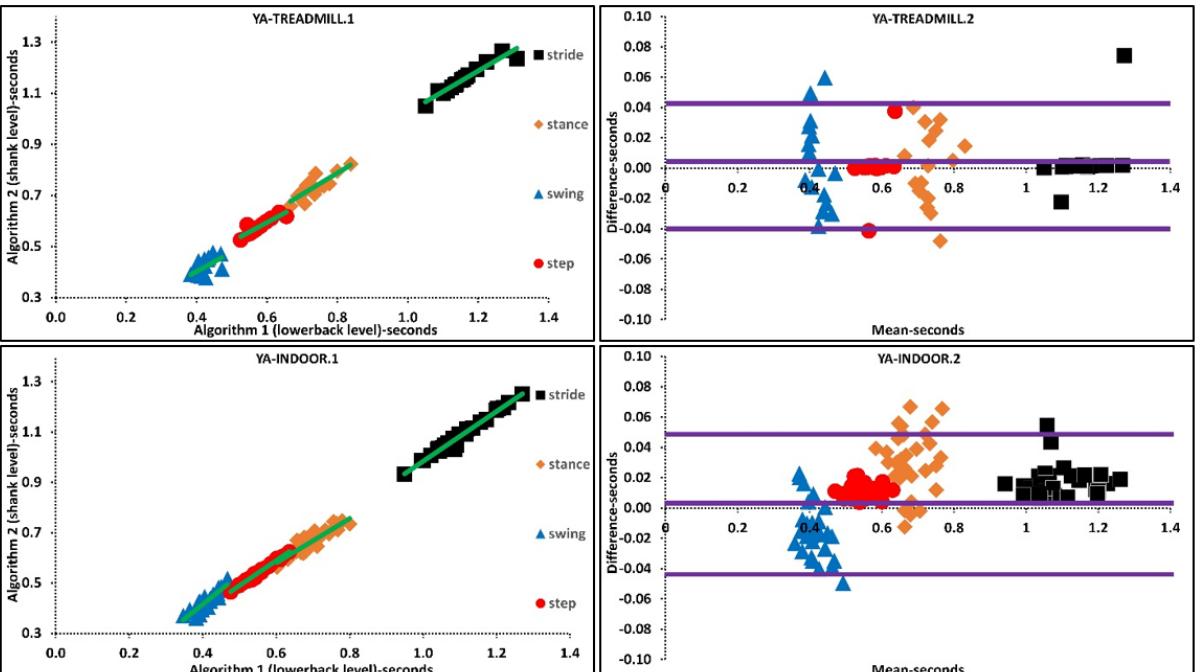
Figure 2. Scatter and Bland-Altman plots of algorithms 1 and 2 for investigating the agreements in older adults (OA) and PD populations by pooling all temporal parameters. OA1, PD1 are scatter plot with regression line (green), respectively. OA2, PD2 are Bland-Altman plotting with mean, lower and upper bands (purple), respectively.